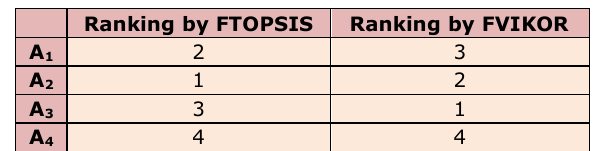
Table 9. Ranking by Fuzzy VIKOR and Fuzzy TOPSIS